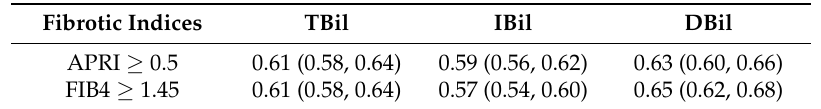
Table 4. Areas under the receiver operating characteristic curve (AUROC) for elevated fibrotic indices for the TBil, IBil and DBil in HBsAg (+)